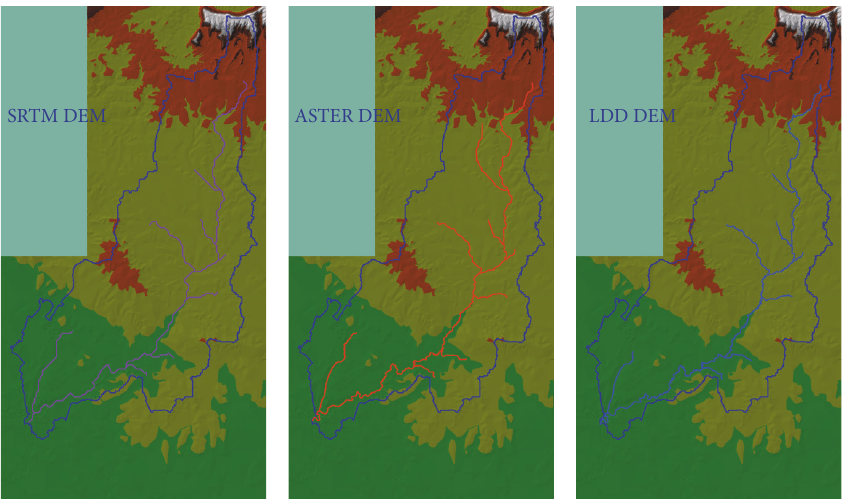
Figure 8: Stream lengths extracted from DEMs of Huai-Sai-Bath subbasin.